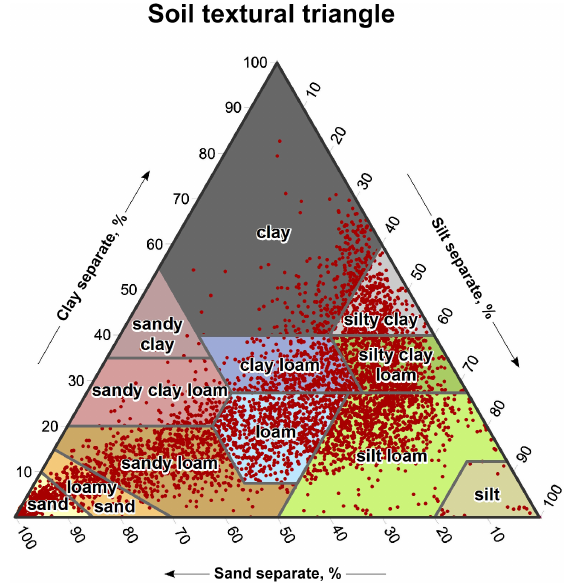
Figure 4. The texture triangle with USDA classification and the distribution of SIMS